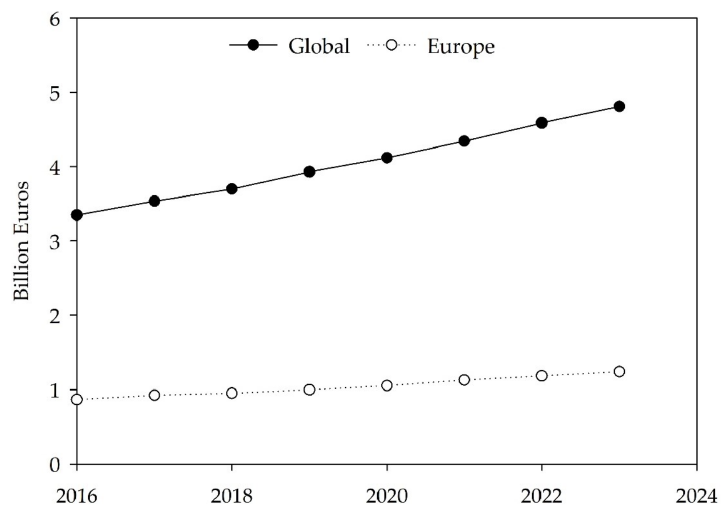
Figure 2. Global and European algae market trends from 2016 to 2023. Data from Statista (2020)